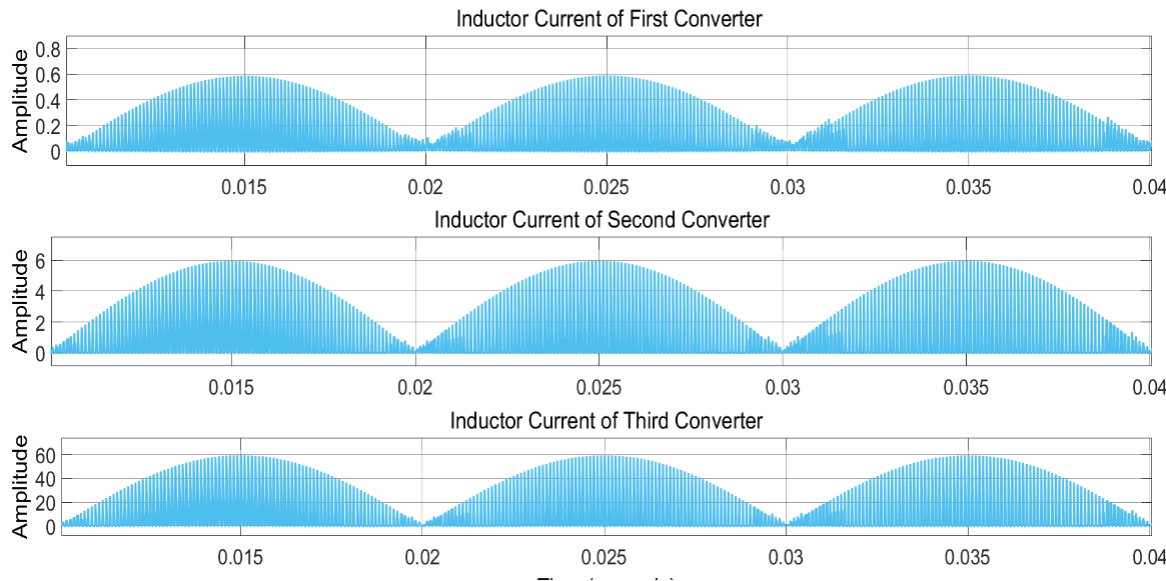
Figure 14. Inductor current waveforms for L 1 = 5 mH, L 2 = 0.5 mH, and L 3 = 0.05 mH.